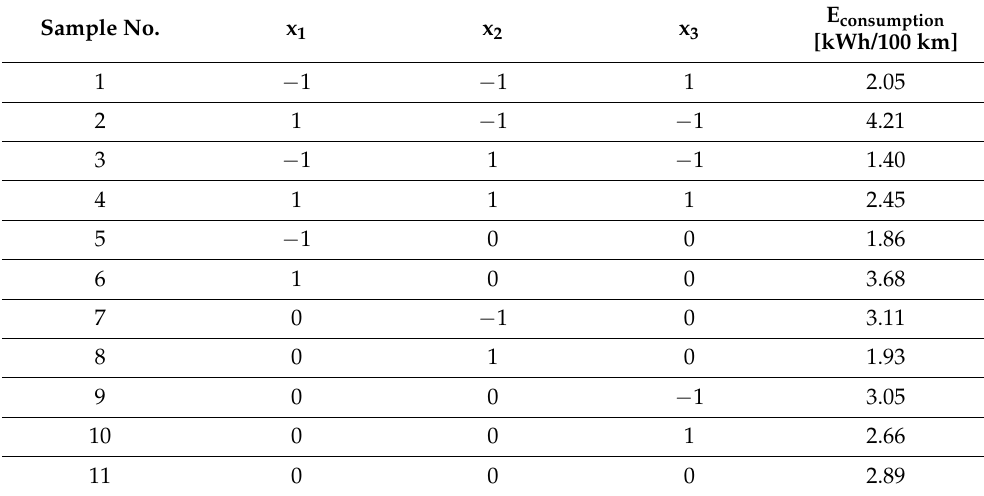
Table 2. Results of the vehicle energy consumption values for the three input factors. Sample No. x